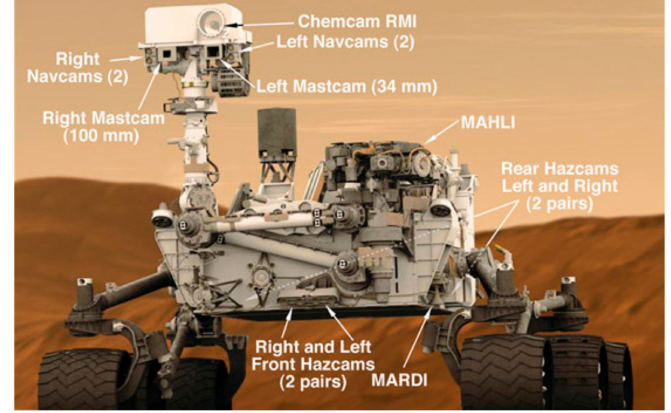
Figure 1. Mars rover Curiosity and its onboard cameras [24]. Mastcam imagers act as eyes of the rover for rock sample selection and rover